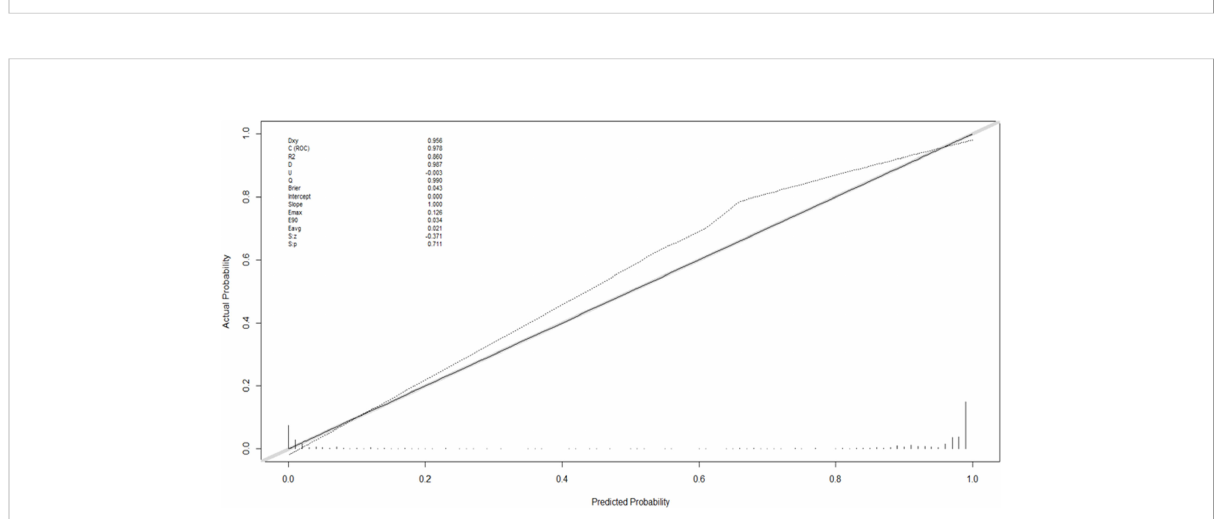
FIGURE 3 The Hosmer-Lemeshow goodness-of- fi t test for the CBCE